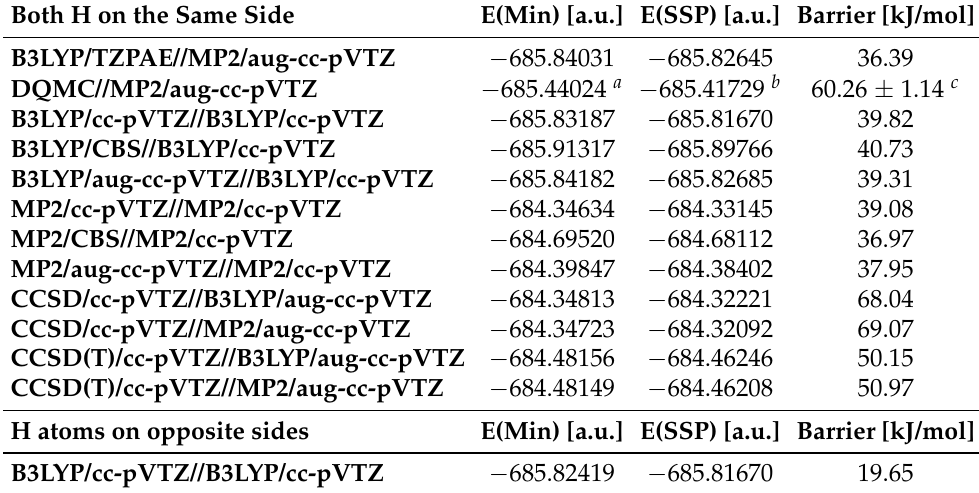
Table 2. Energy barrier for synchronous double proton transfer in Naphthazarin through the second- order saddle point (SSP) computed at various levels of theory including Diffusion Monte Carlo (DMC) method. The levels of theory are given using the usual convention level1//level2 indicating single point energy at level 1 for the structure optimized at level